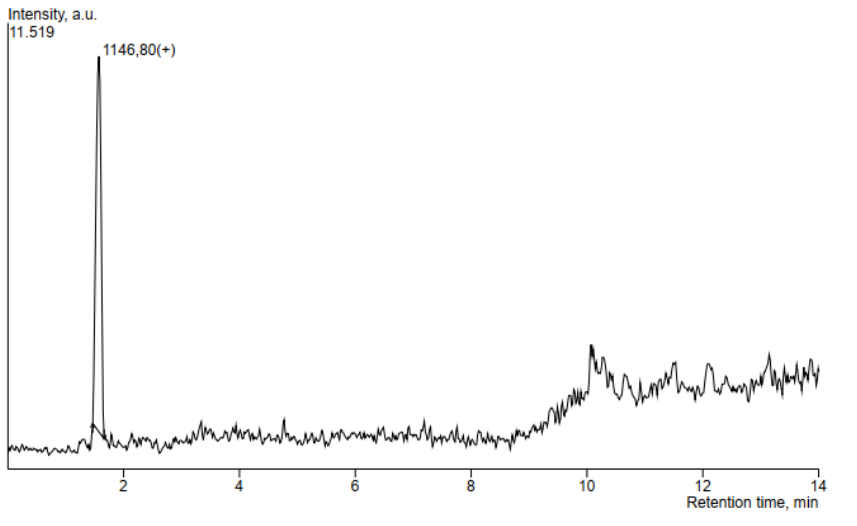
Figure 8. SIM chromatogram of the antimicrobial compound from the locillomycin family putatively identified in the supernatant of B. velezensis IP22 cultivation broth.